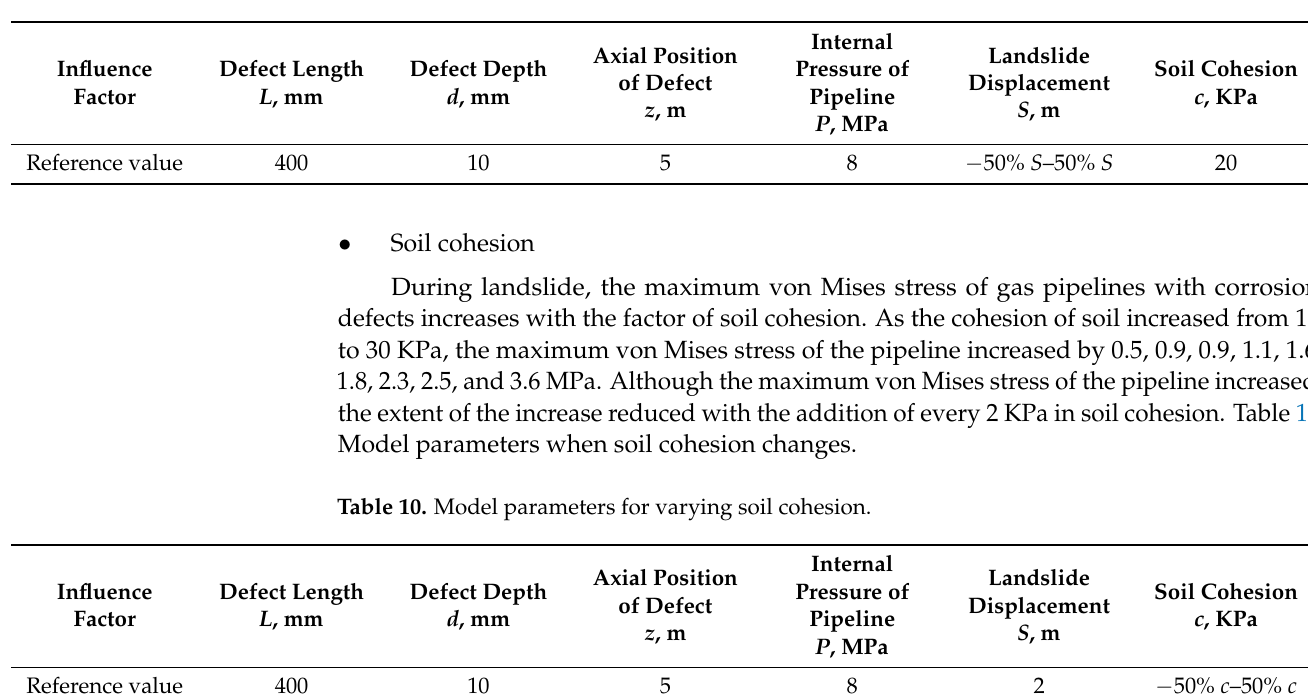
Table 9. Model parameters for varying landslide displacement.